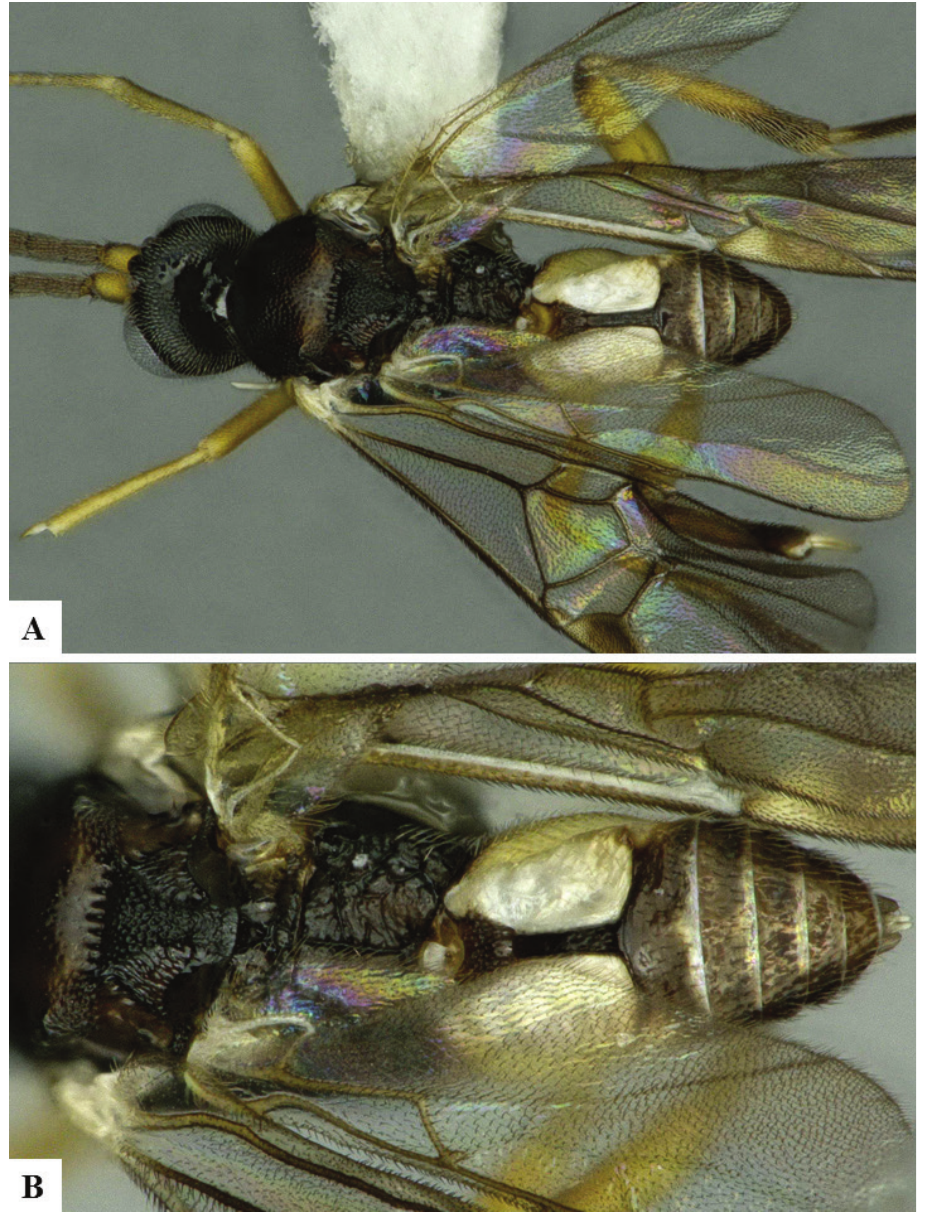
Figure 47. Zachterbergius tenuitergum male paratype JMIC 0538. A Habitus dorsal B Mesosoma and metasoma,